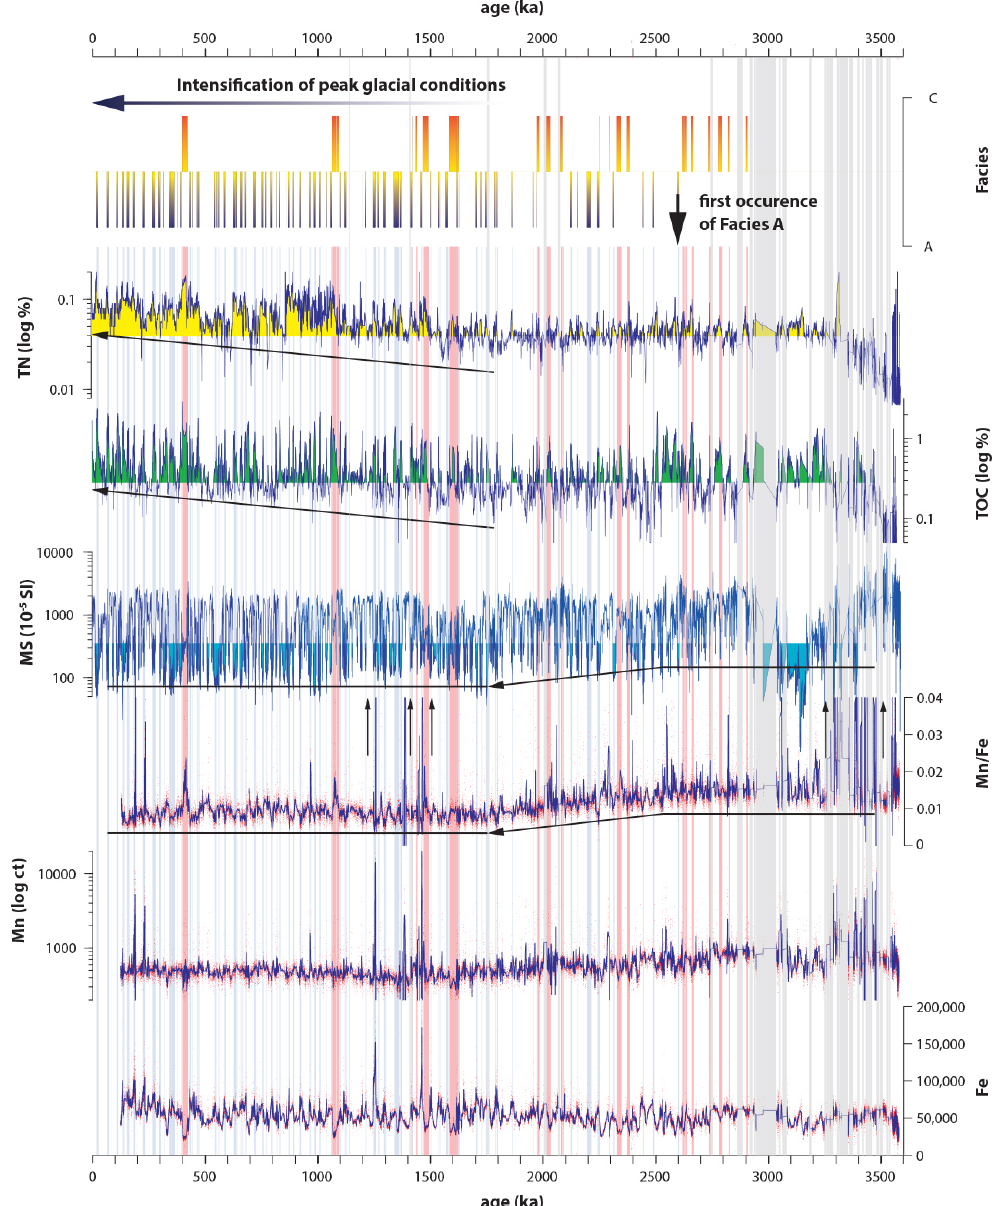
Figure 5. XRF scanning Fe and Mn intensities and Mn/Fe ratios as well magnetic susceptibility (MS; Nowaczyk et al., 2013), total organic carbon (TOC), total nitrogen (TN) contents, and the occurrence of sediment facies A and C in the sediment record from Lake El’gygytgyn vs. age. XRF data are plotted as raw data (blue dots) and 101-point weighted running average (colored lines). Magnetic susceptibility data are smoothed by 500-year weighted running mean to improve the signal-to-noise ratio. Blue and red bars mark the occurrence of sediment facies A and C. Gaps in the record are shaded with grey bars. Please not the logarithmic scaling of the Mn, TN, TOC, and MS scales. Vertical arrows in the Mn/Fe record mark values beyond 0.4 that were cropped due to displaying